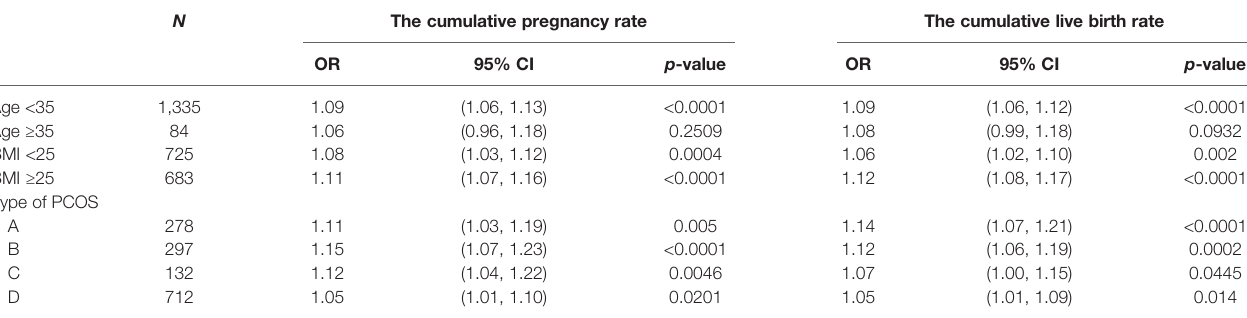
TABLE 5 | Strati fi ed analysis of the number of oocytes retrieved and cumulative clinical outcomes. N The cumulative pregnancy